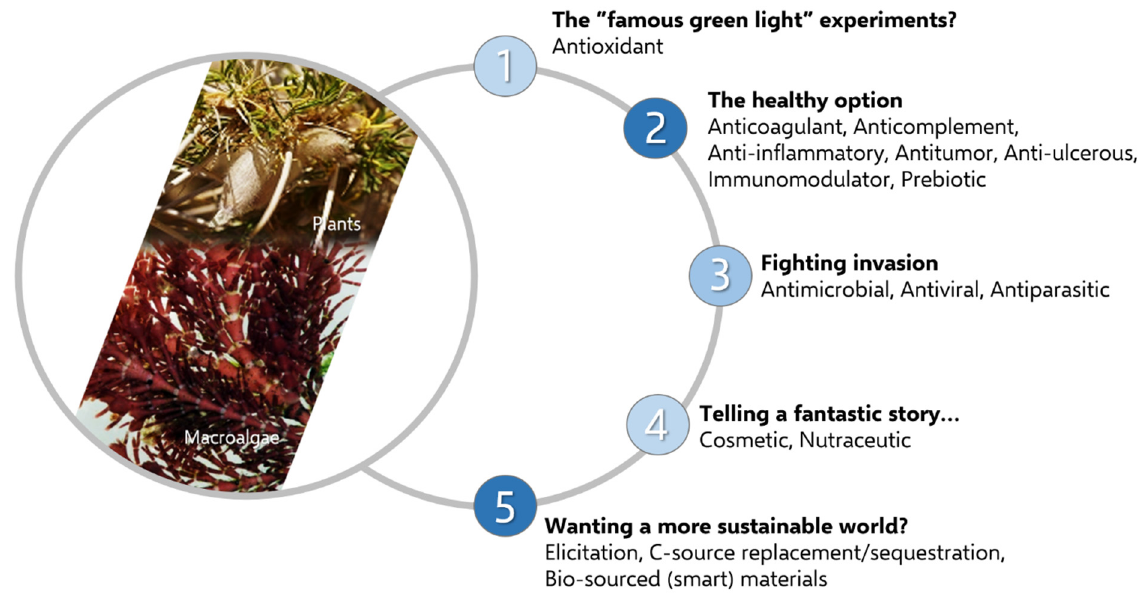
Figure 4. The first questions before screening the biological potential of (African) polysaccharides.